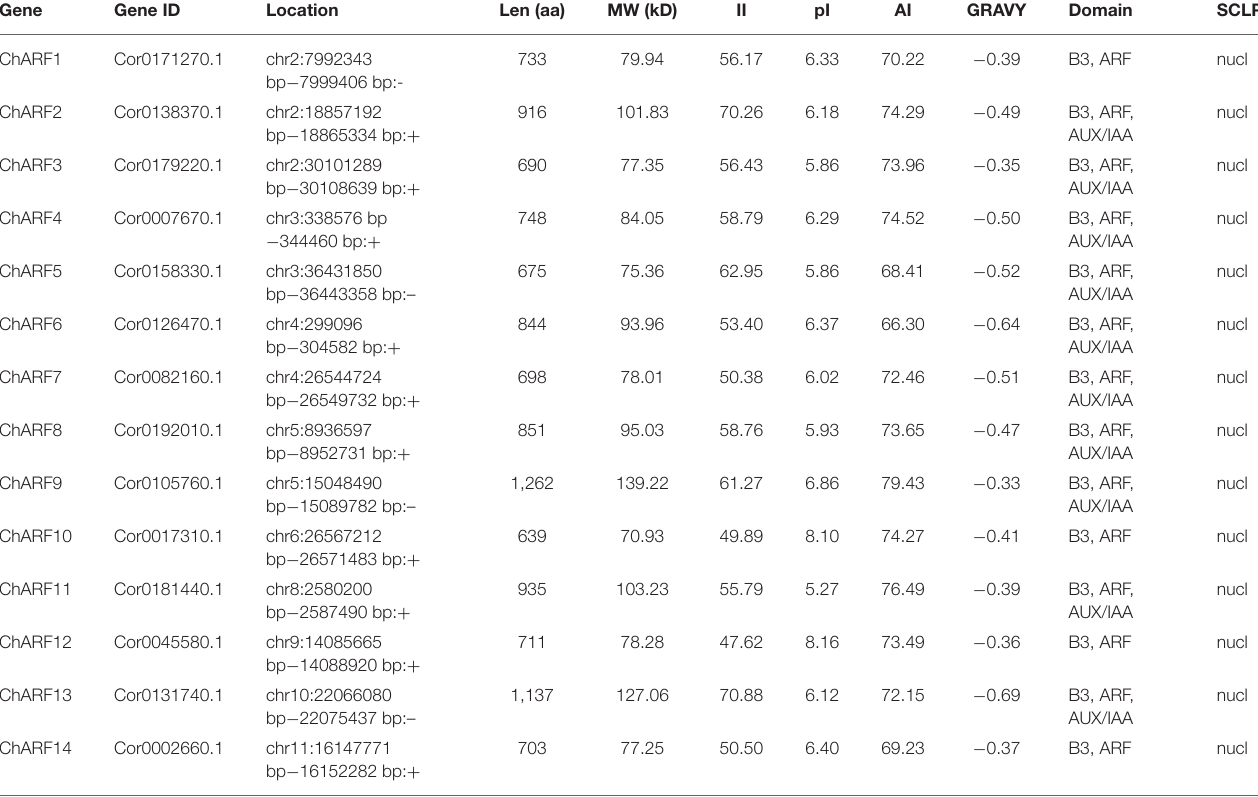
TABLE 1 | Detailed information of the ARF family genes in